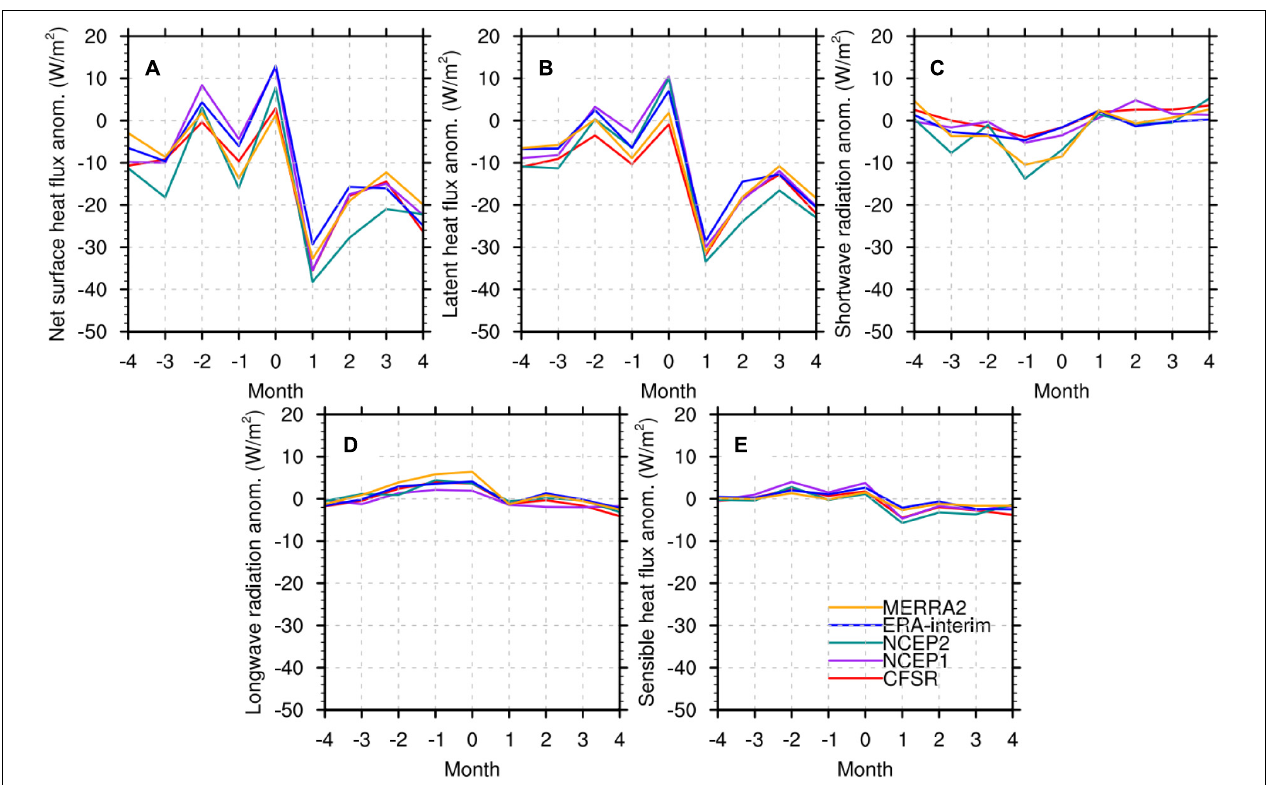
FIGURE 7 | Composites of the monthly mean net surface heat flux (A) , latent heat flux (B) , shortwave radiation (C) , longwave radiation (D) and sensible heat flux (E) anomalies over the region (110 ◦ E-116 ◦ E, 22 ◦ S-32 ◦ S) for Ningaloo Niño years. The sign of the longwave radiation, latent and sensible heat flux has been adjusted so that positive values indicate the warming of the ocean. Month 0 is the month of the maximum positive SST anomaly.